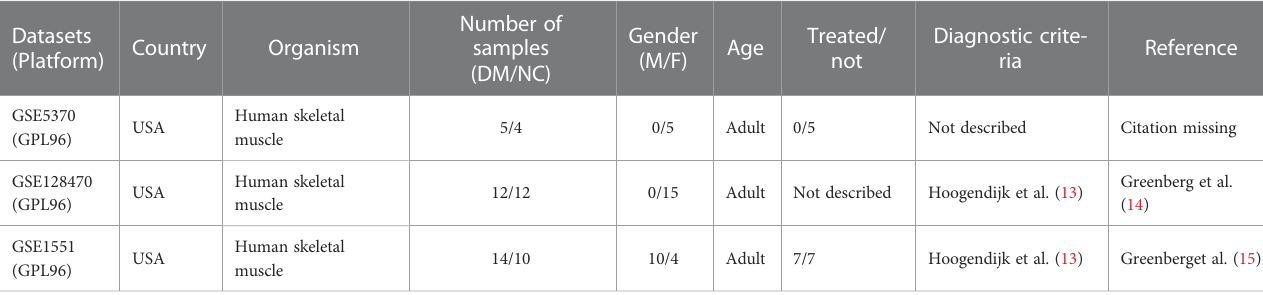
TABLE 1 Basic information on DM muscle